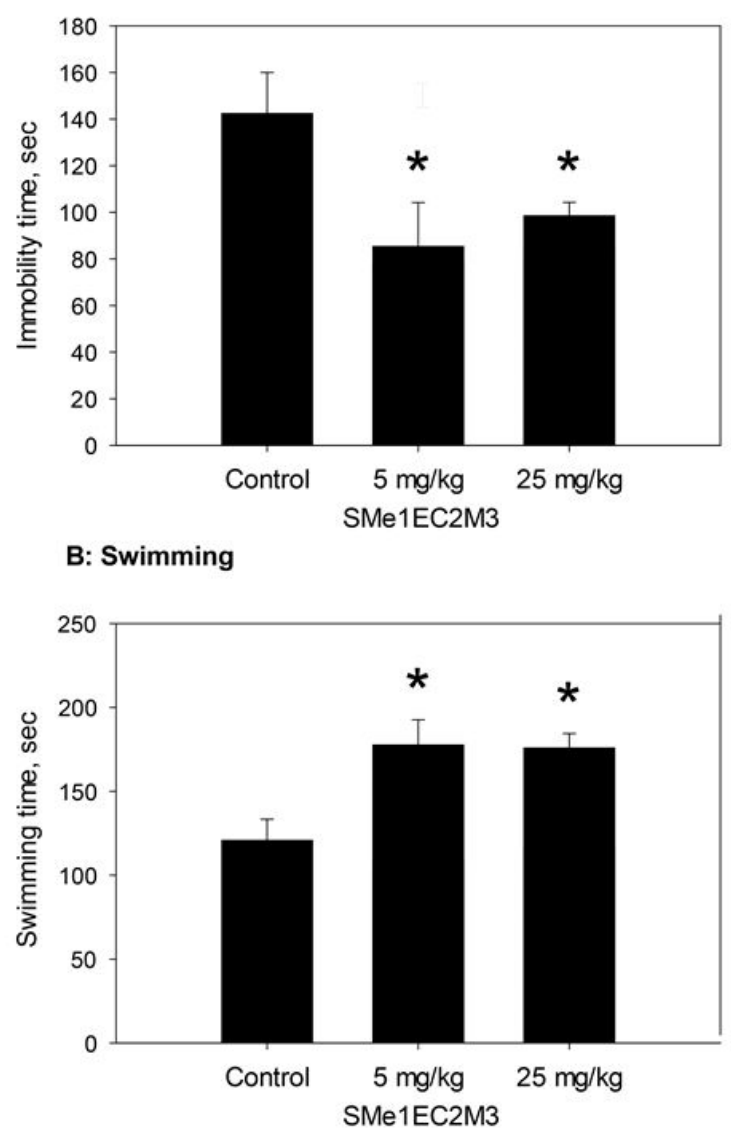
Figure 2. E ff ects of SMe1EC2M3 on the behavioral characteristics of Wistar rats. ( A ): immobility time during the FST test; ( B ): swimming time during the FST; * p < 0.05, Fisher´s LSD post-hoc